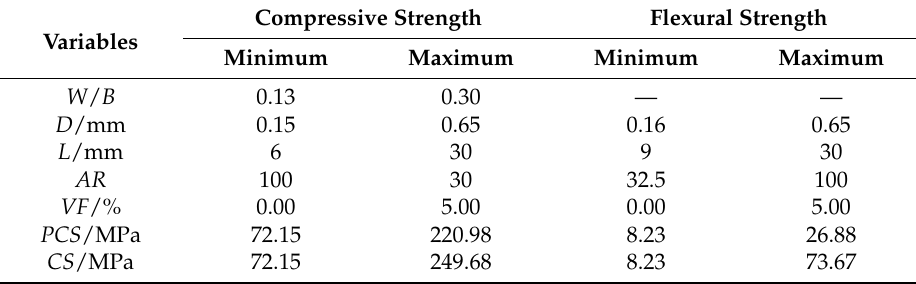
Table 3. Ranges of Parameters in Compressive Strength and Flexural Strength Data base.